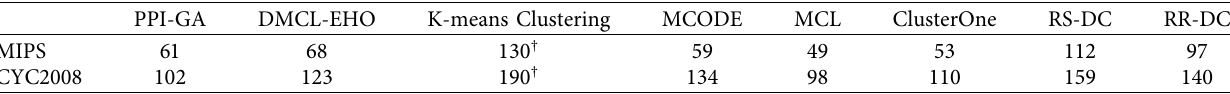
Table 12: Comparison of average execution time of the proposed algorithm with the existing algorithms in terms of time (minutes). PPI-GA DMCL-EHO K-means Clustering MCODE MCL ClusterOne RS-DC RR-DC MIPS 61 68 130 † 59 49 53 112 97 CYC2008 102 123 190